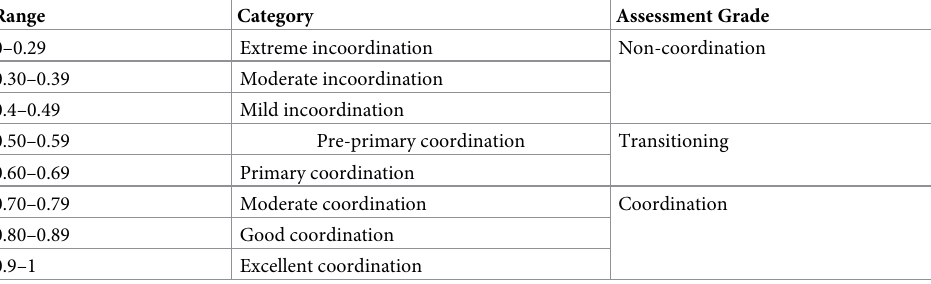
Table 3. Evaluation criteria of the degree of coupling